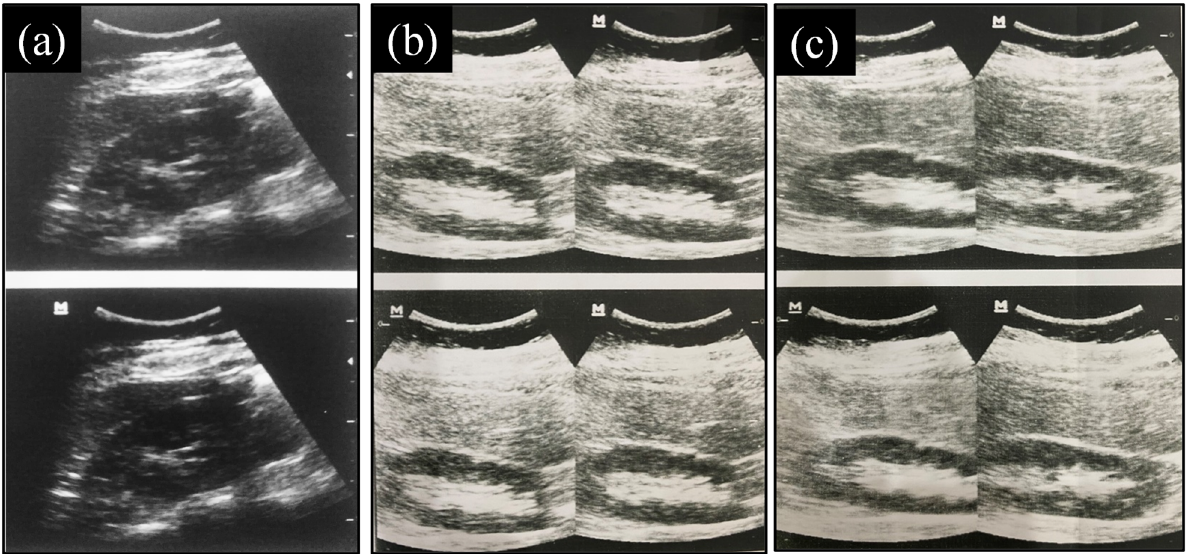
Figure 9. Ultrasound image of the right kidney produced ( a ) without any conductive medium, ( b ) when a selected formulation (S1) was applied to the skin, and ( c ) when a commercial gel (CG) was applied to the skin.